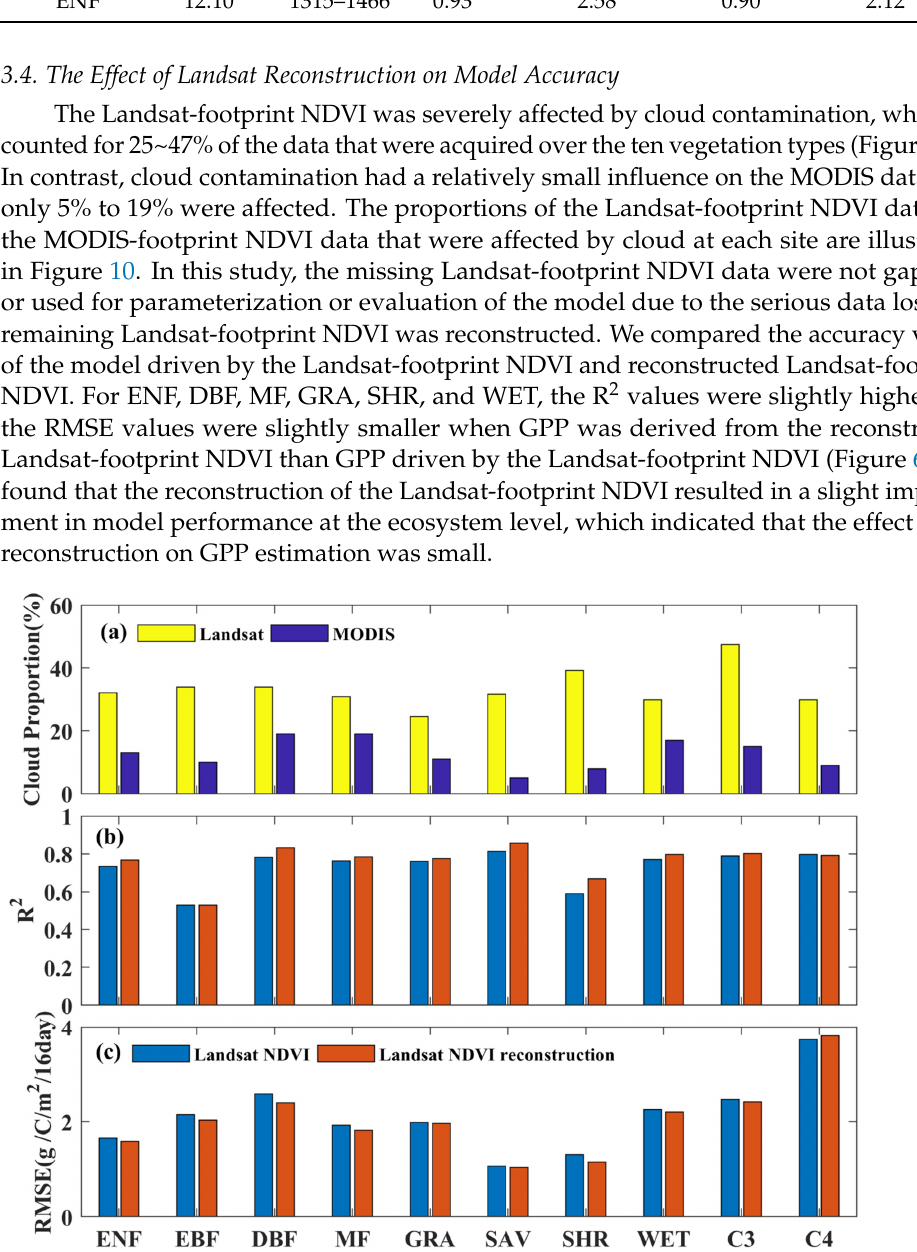
Figure 10. ( a ): The cloud proportion of Landsat NDVI and MODIS NDVI at the 78 sites; ( b , c ): the value of R 2 and RMSE of GPP estimation driven by Landsat NDVI and reconstructed NDVI among the ten vegetation types.